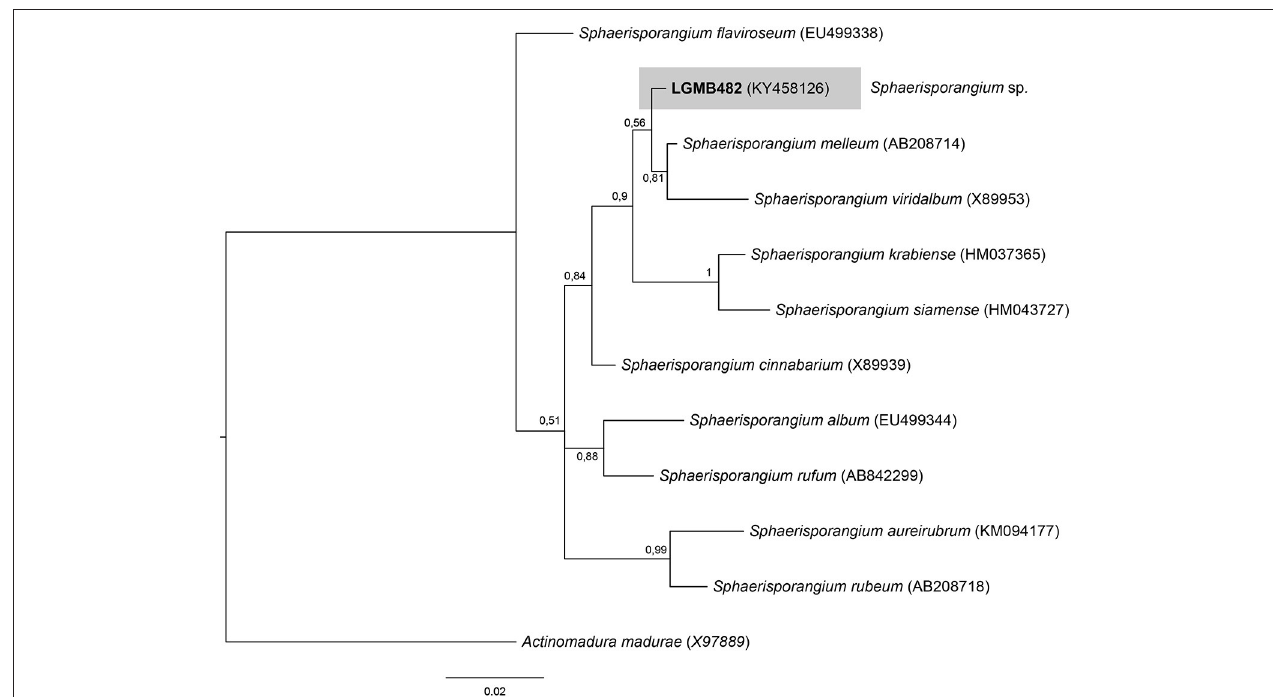
FIGURE 6 | Bayesian phylogenic tree based on 16S rRNA gene of LGMB482 and the 10 type strain of Sphaerisporangium genus. Values on the node indicate Bayesian posterior probabilities. The species Actinomadura madurae was used as out group. Scale bar indicates the number of substitutions per site.